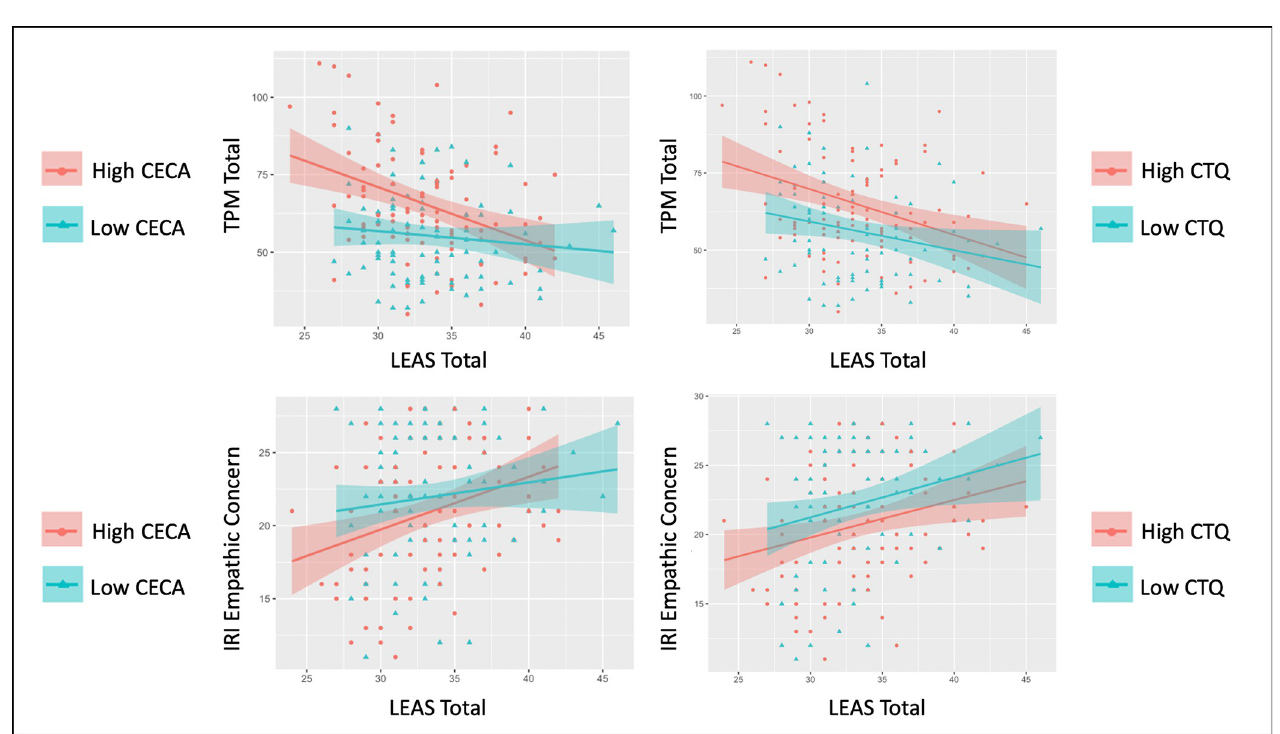
Fig 2. Effects of early adversity on the relationships between emotional awareness, psychopathy, and empathy measures. This figure shows correlations between Levels of Emotional Awareness (LEAS) Total Scores and both Triarchic Psychopathy Measure (TPM) Total scores and Interpersonal Reactivity Index (IRI) Empathic Concern scores, separated by high vs. low levels of early adversity (based on median splits). Early adversity measures included the Childhood Experiences of Care and Abuse questionnaire (CECA) and the Childhood Trauma Questionnaire (CTQ). The High-CECA group had 24/40 males and 65/133 females. The High-CTQ group had 21/39 males and 72/133 females. This visual comparison between individuals with high and low levels of early adversity illustrates the significant interaction observed in the main analyses between emotional awareness and early adversity in predicting psychopathy and empathic